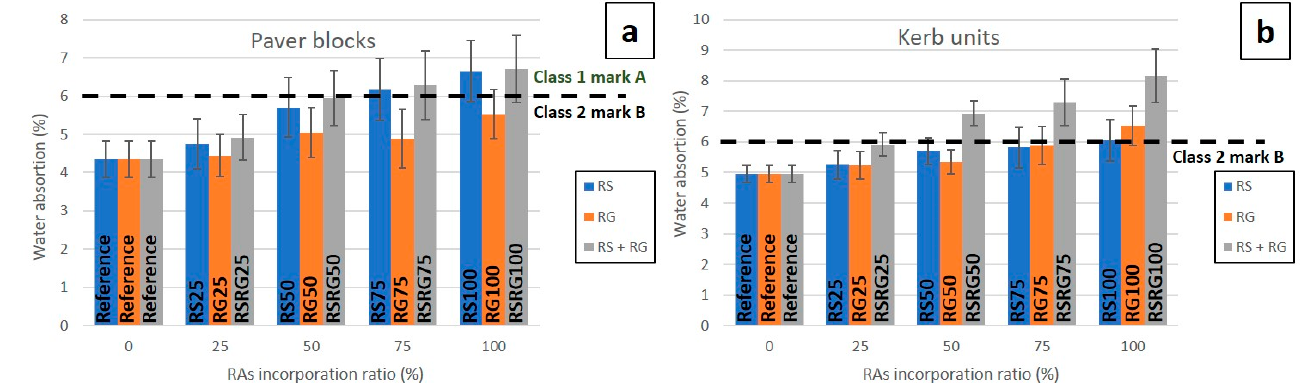
Figure 3. Graphical representation of water absorption vs. RAs’ incorporation ratio in pavers ( a ) and kerbs ( b ).